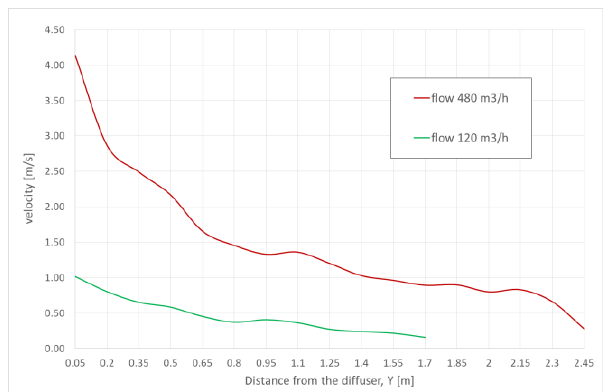
Fig. 10 . Distribution of velocity along the SLN diffuser axis for downflow.